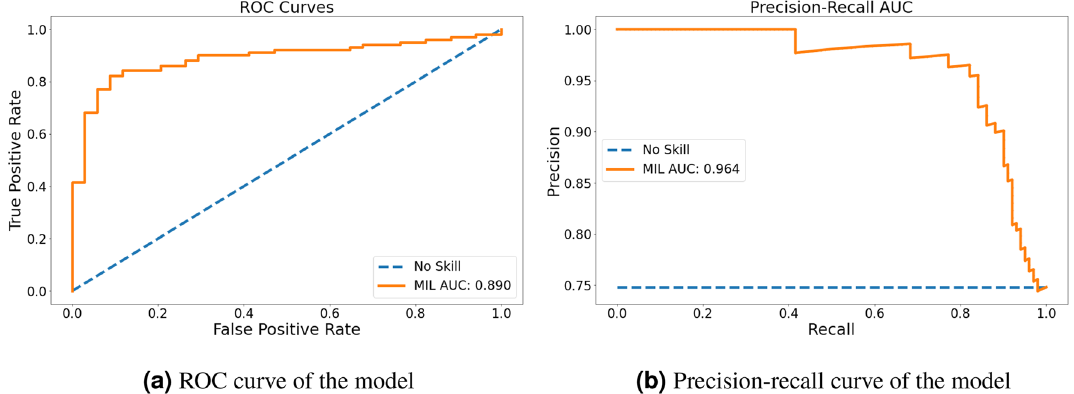
Figure 3. Varying the final probability threshold yields the receiver operator characteristics shown in ( a ) and the precision-recall curve in ( b ). Orange represents our proposed method.